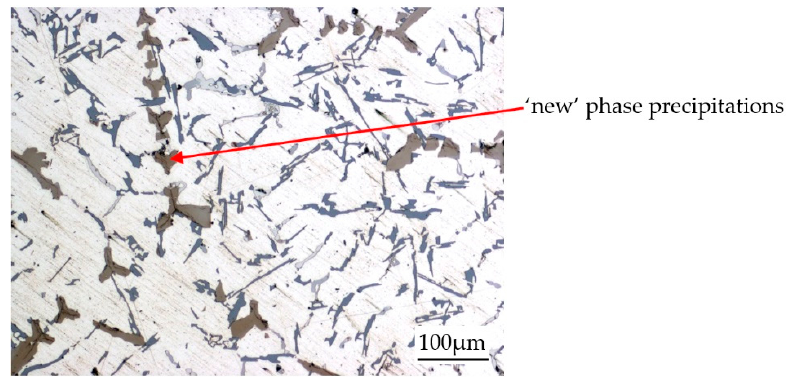
Figure 10. Microstructure of Al-Si alloy with approximately 0.3 wt % Cr in the shell sand probe: Al 15 (Fe,Mn,Cr) 3 Si 2 , α (Al), α + β , α + Al 2 Cu + AlSiCuFeMgMnNiCr + β .